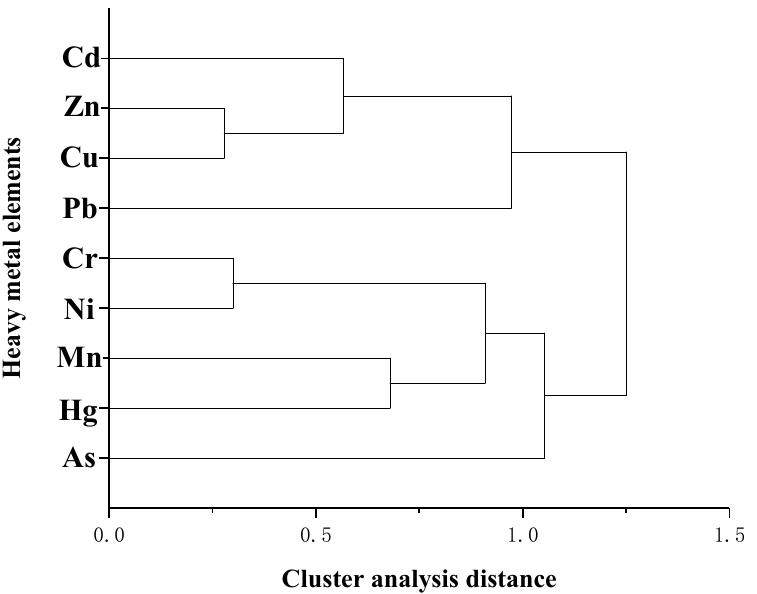
Figure 9. Cluster analysis of heavy metal concentration in farmland soils of Shaanxi Province.